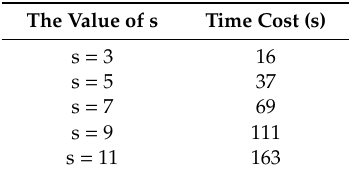
Table 1. The time cost for the algorithm to process one image, when s takes di ff erent values. The Value of